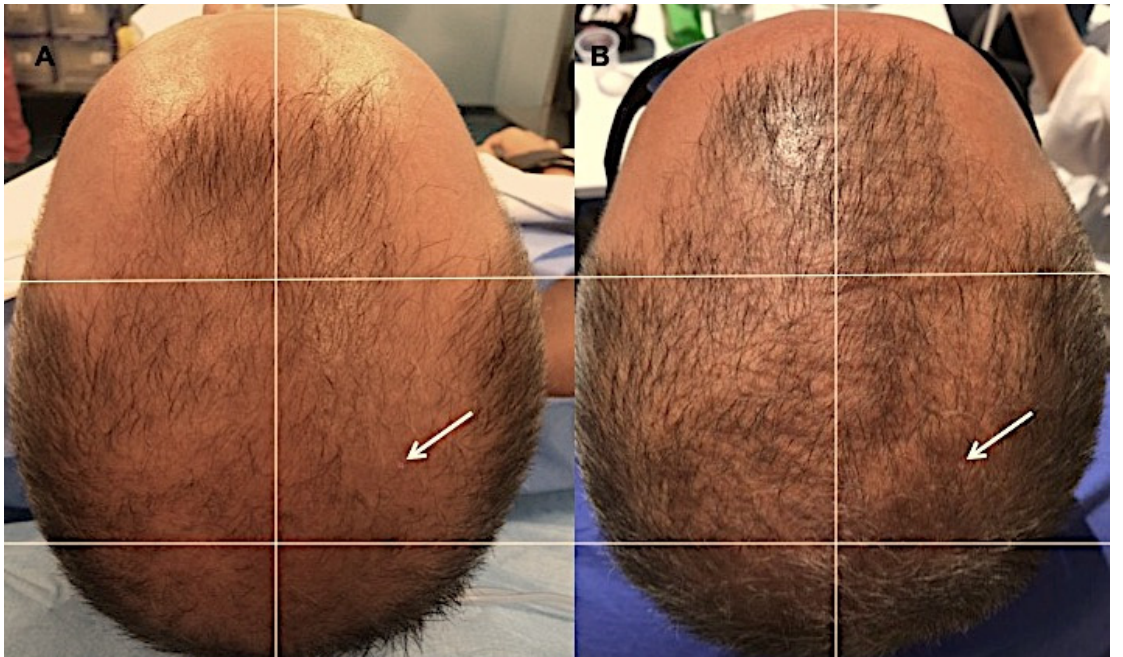
Figure 2. A smoker 43-year-old male patient classified as Androgenic alopecia (AGA) 4 according to the Norwood–Hamilton Scale, in baseline and after Human Intra and Extra Dermal Adipose Tissue-Derived Hair Follicle Stem Cells (HD-AFSCs) treatment. ( A ) Timing T0 (before the treatment) with hair loss localized to the vertex, parietal, temporal, and frontal areas, ( B ) Timing at T5, 44 weeks after the last micro-grafts injection with an increase of hair density in the targeted area. White arrow indicates the demarcated point in which the histological analysis and Trichoscan evaluation were performed.